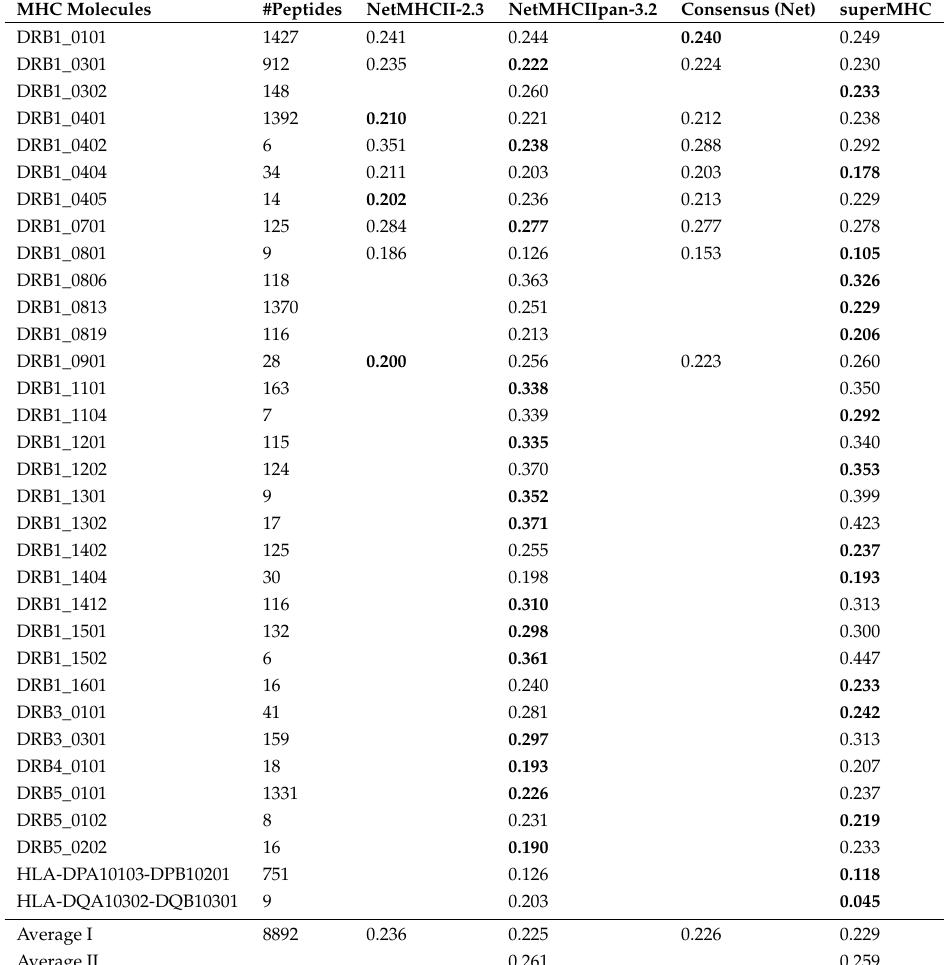
Table 4. Predictive performance of the superMHC method compared with those of NetMHCII-2.3, NetMHCIIpan-3.2, and their consensus method on the new test set in terms of RMSE. MHC